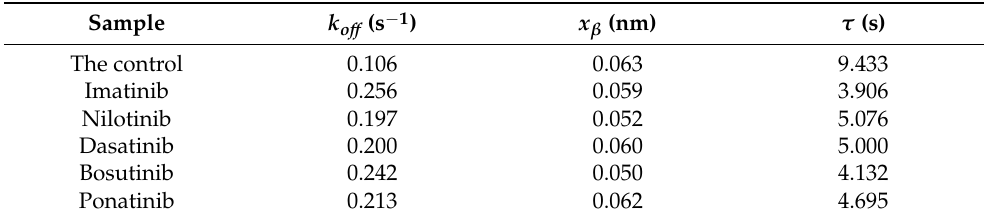
F - I n ( r ) interaction